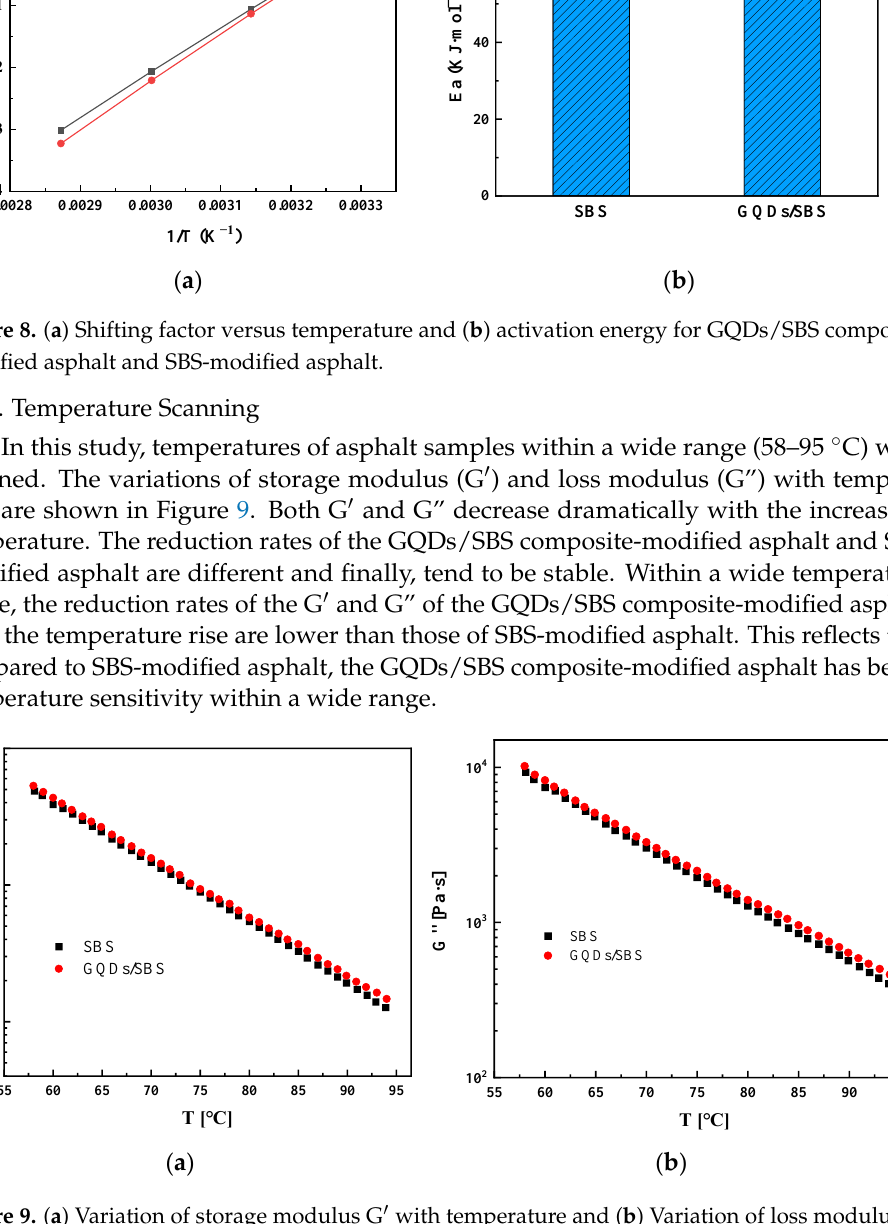
Figure 7. ( a ) Master curves for GQDs/SBS composite-modified asphalt and SBS-modified asphalt at the reference temperature of 30 °C and ( b ) Variations of the translocation factor with temperature.